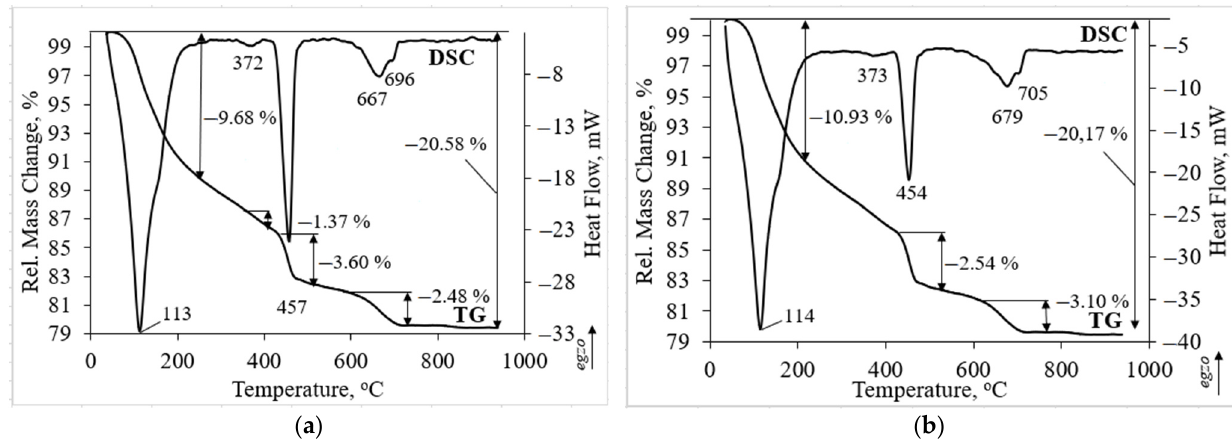
Figure 6. Thermal analysis of hardened cement paste samples after 28 days: ( a ) 50TW/50WW sample; ( b ) Z50TW/50WW sample.